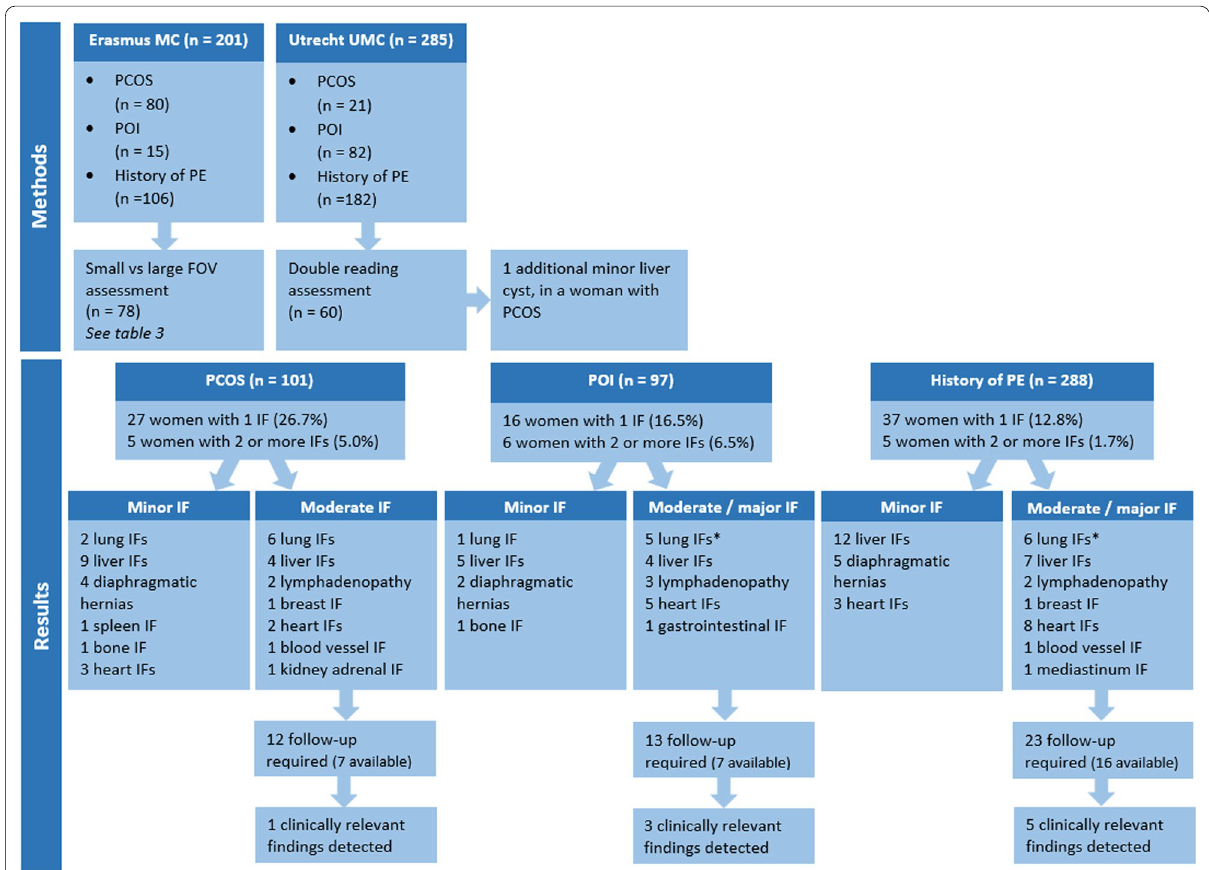
Fig. 2 Flowchart methods and results. The IFs shown in this figure are IFs detected in the small FOV. *Major IFs, in the POI group it included 2 major lung IFs and in the PE group 1 major lung